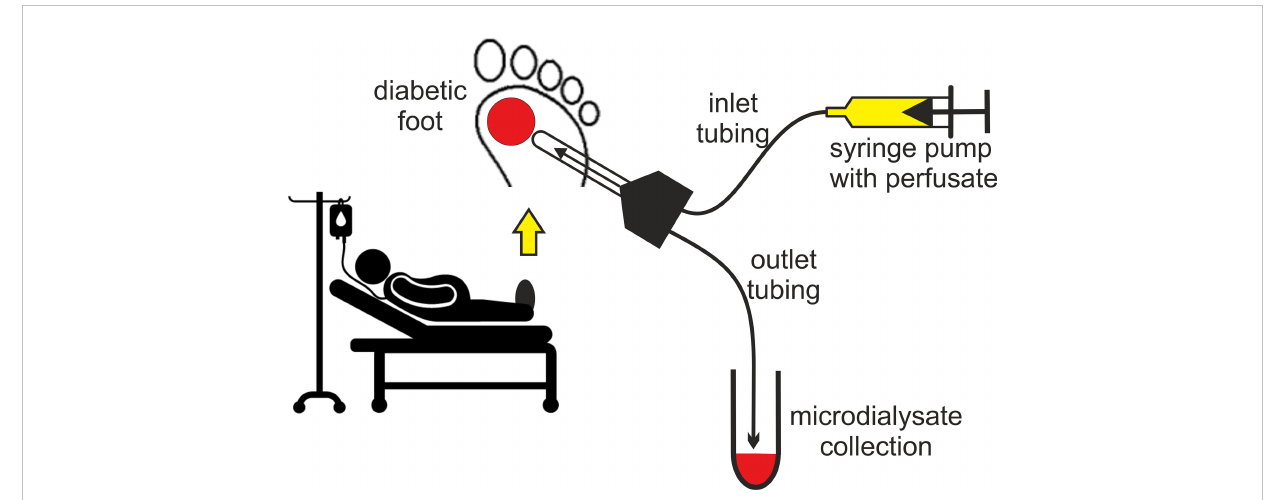
FIGURE 4 Assessment of tissue ATB concentrations using microdialysis in DF patients treated with intravenous